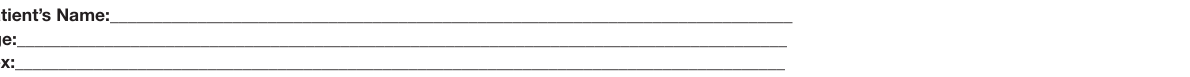
TABLE 5 | Relevant risk factors concerning cardiovascular and hypertensive clients/patients before